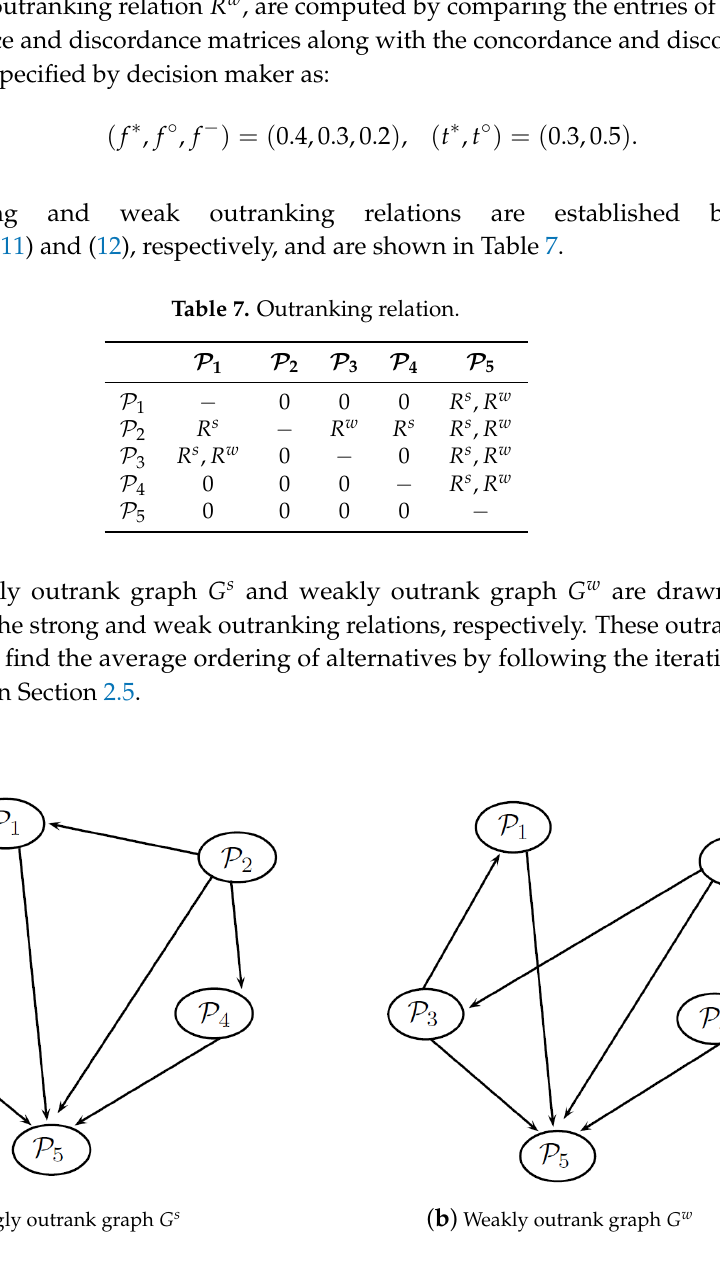
Figure 2. Graphical representation of outranking relations between